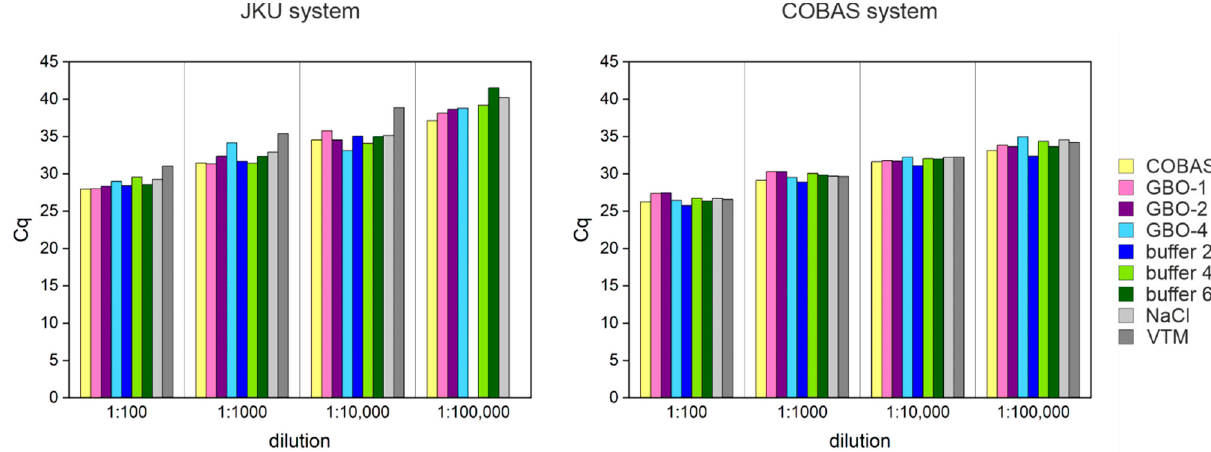
Figure 5. Effect of lysis buffer on test performance. Shown are measured Cq values of a positive sample pool diluted in different lysis buffers in a 1:10 dilution series. Different colored bars in the plot represent the buffers used measured with our in-house system (JKU system) and the Roche COBAS system.